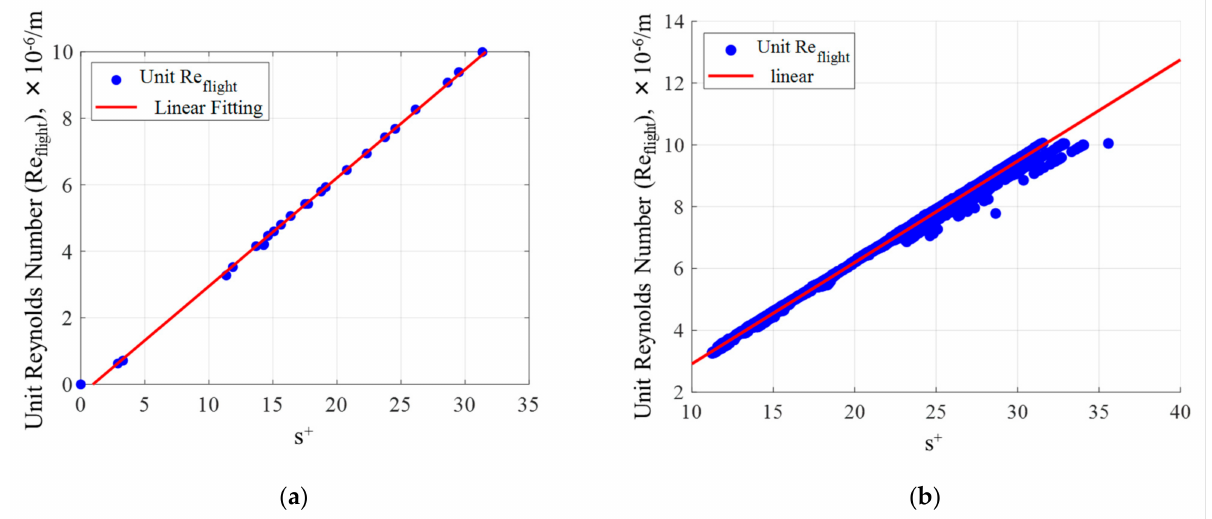
Figure 3. Relationship between s + and unit Reynolds number for: ( a ) on-design (target) cruise conditions; ( b ) all conditions from time-series data over Mach